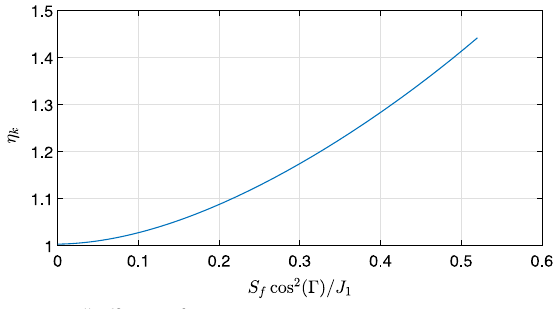
Fig. 6 Hull-efficiency factor η k [15]